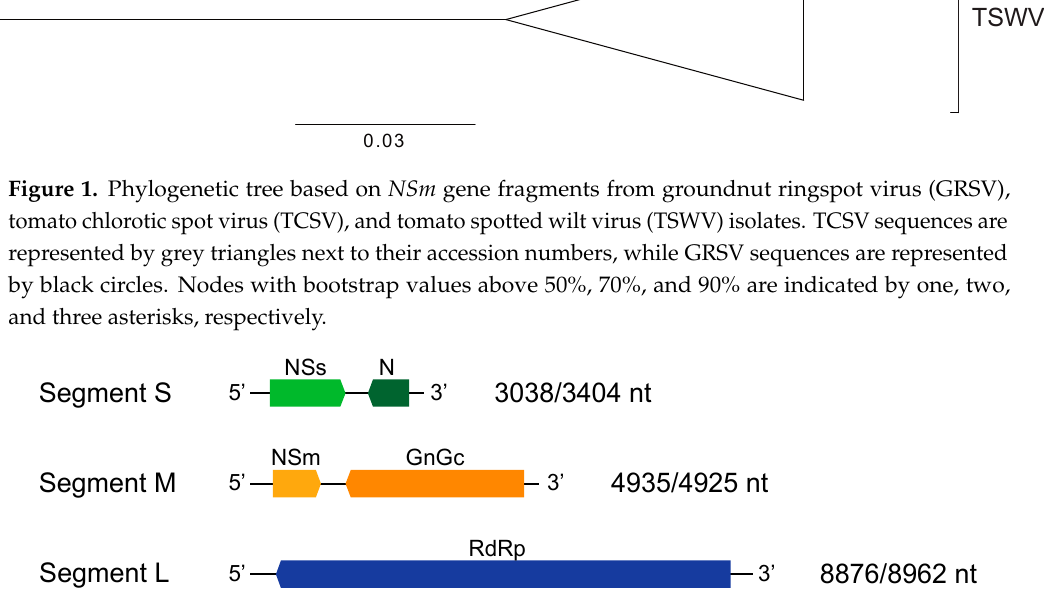
Figure 1. Phylogenetic tree based on NSm gene fragments from groundnut ringspot virus (GRSV), tomato chlorotic spot virus (TCSV), and tomato spotted wilt virus (TSWV) isolates. TCSV sequences are represented by grey triangles next to their accession numbers, while GRSV sequences are represented by black circles. Nodes with bootstrap values above 50%, 70%, and 90% are indicated by one, two, and three asterisks, respectively.